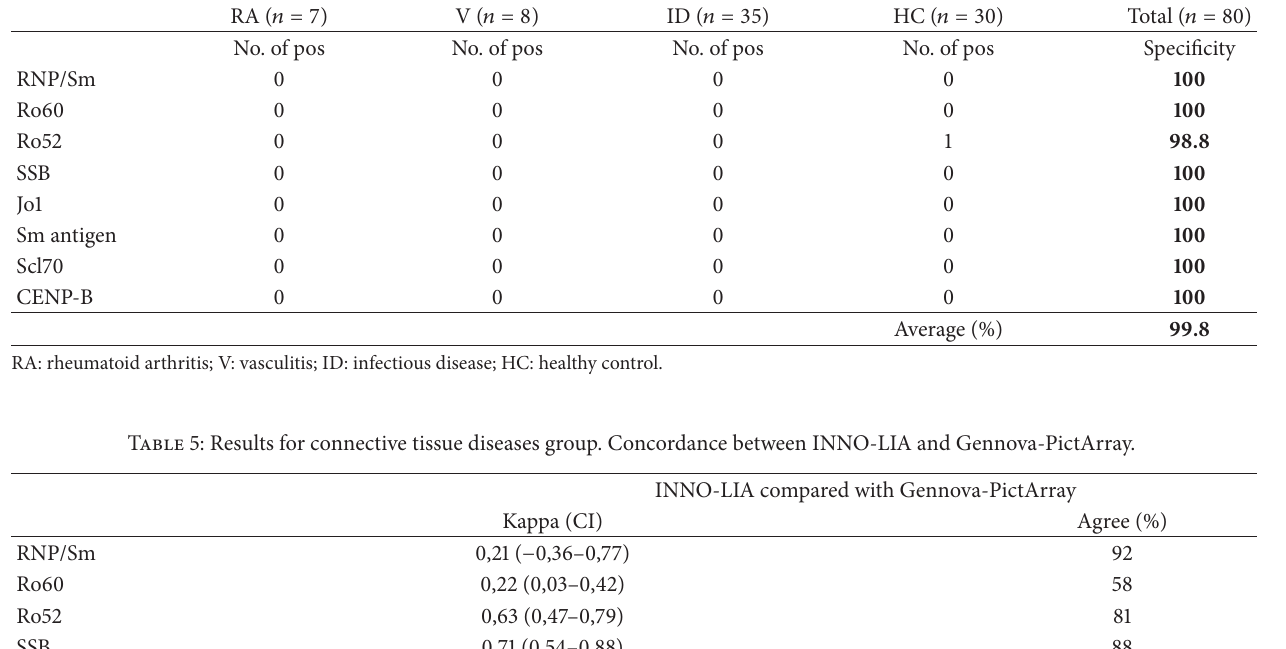
Table 4: Prevalence of autoantibodies detected by Gennova-PictArray in different control groups.